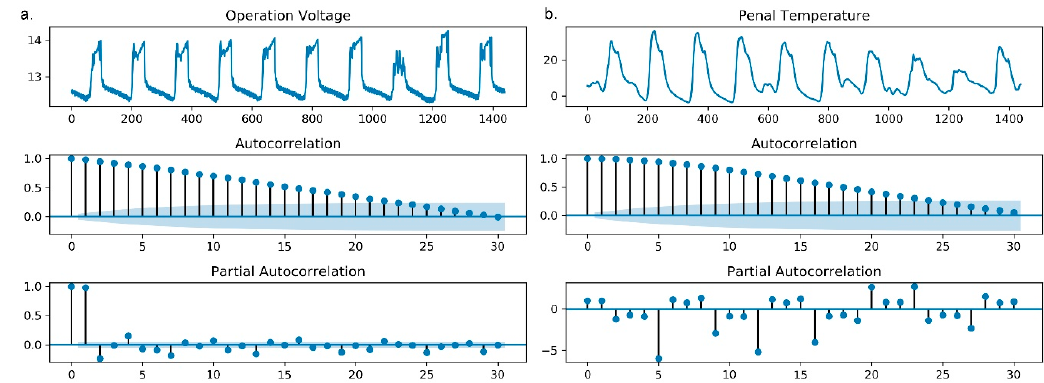
Figure 4. The plots of the autocorrelation function (ACF) and partial autocorrelation function (PACF) of the operating voltage and panel temperature calculated from 30 logs. ( a ) The ACF and PACF of the operating voltage; ( b ) the ACF and PACF of the panel temperature.